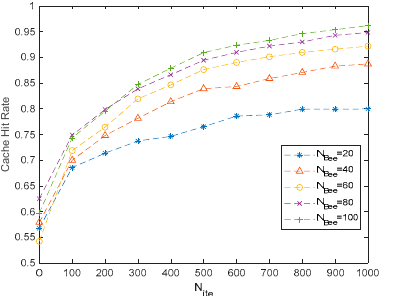
Figure 7. Cache hit rate of DABCC for different iteration times.